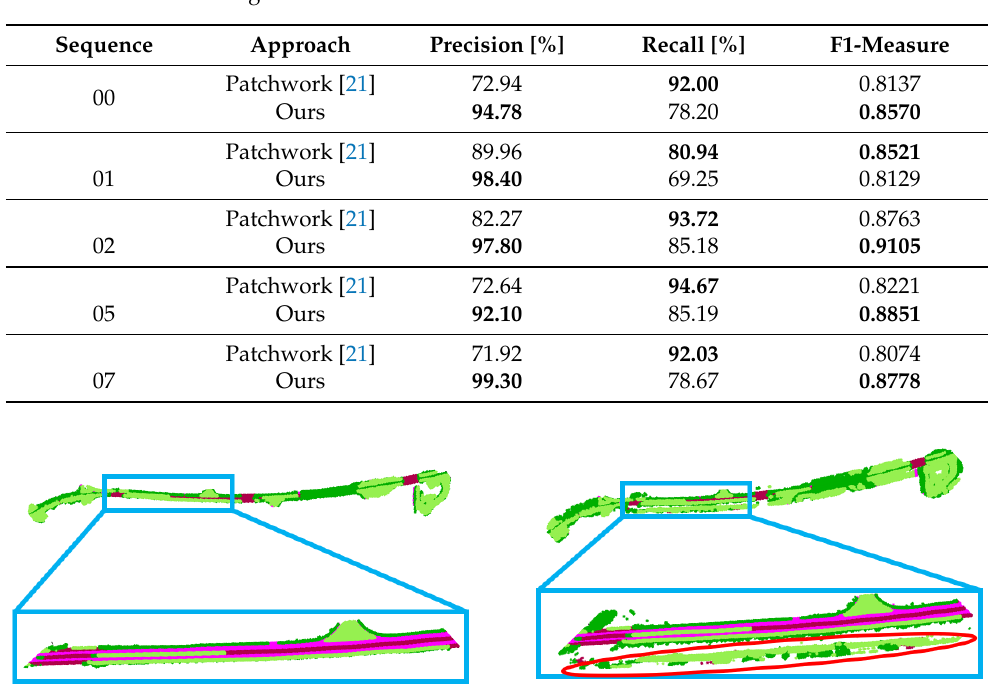
Figure 8. The left figure shows the terrain modeling results from the proposed method on Sequence 01, and the right figure shows the ground truth. It can be seen that the ground truth contains terrain outside the main road. These areas are considered unreachable to vehicles, so they are not modeled by the proposed approach, thus resulting in a relatively low recall. The points are colored according to the semantic